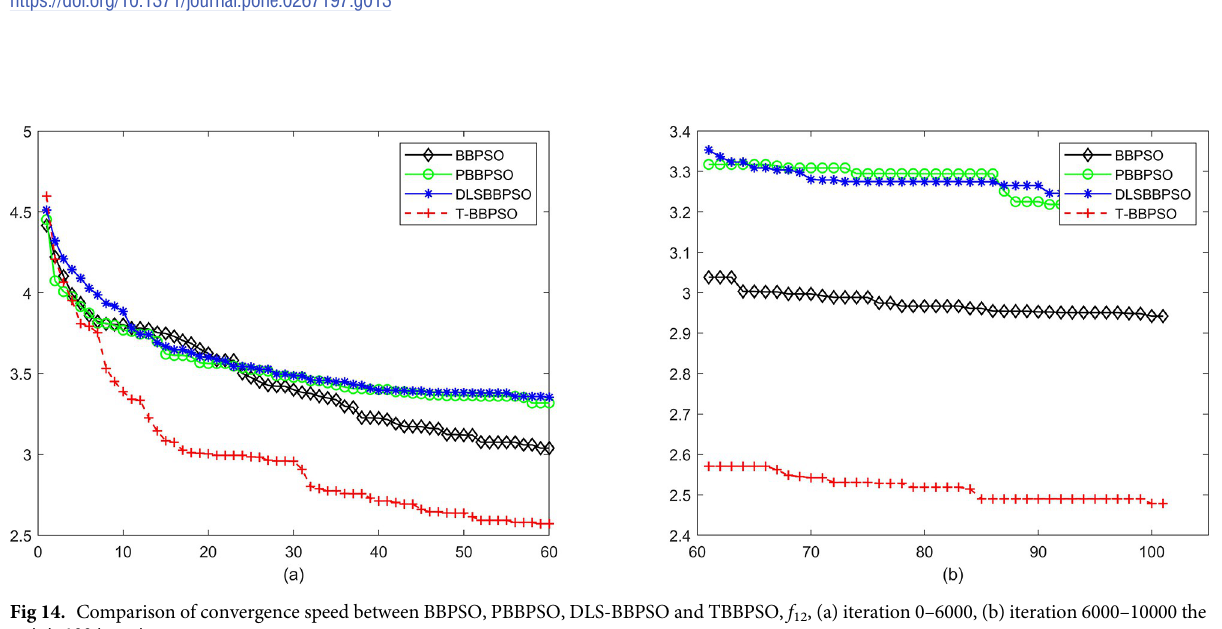
Fig 13. Comparison of convergence speed between BBPSO, PBBPSO, DLS-BBPSO and TBBPSO, f 11 , (a) iteration 0–6000, (b) iteration 6000–10000 the unit is 100 iteration.